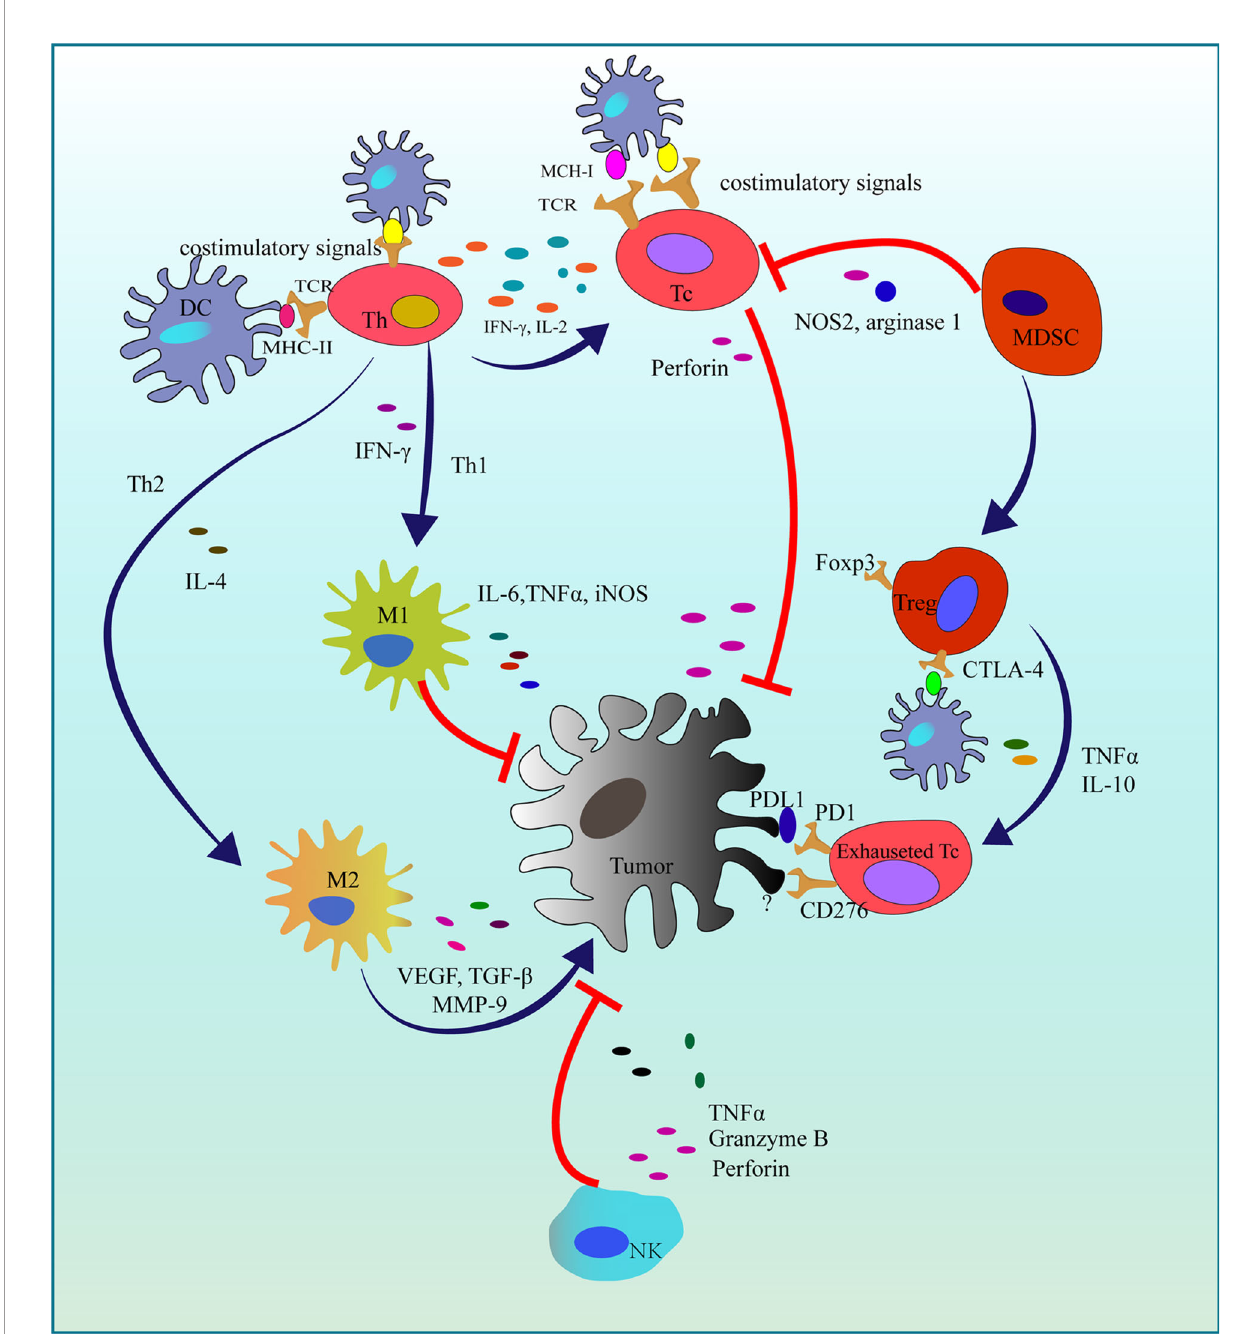
FIGURE 3 | Immune responses in the tumor microenvironment. In the initiation of tumorigenesis, activated Tc and NK cells suppress tumor proliferation. While in the immune evasion, Th2 recruits MDSC and promotes macrophages polarization (M1 to M2). Finally, survived tumor cells exhaust Tc cells by some immune checkpoints. DC, Dendritic cell; MCH-1, Major histocompatibility complex class I; MCH-II, Major histocompatibility complex class II; TCR, T cell receptor; Th, T helper cell; Th1, T helper 1 cell; Th2, T helper 2 cell; Tc, Cytotoxic T cell; IFN- g , Interferon-gamma; Treg, Regulatory T cell; Foxp3, Forkhead box Protein 3; MDSC, Myeloid- derived suppressor cell; NOS2, Nitric Oxide Synthase 2; TNF a , Tumor necrosis factor-alpha; IL-2, Interleukin 2; IL-6, Interleukin 6; iNOS, Inducible nitric oxide synthase; M1, Macrophage 1; M2, Macrophage 2; PD-1, Programmed cell death protein 1; PD-L1, Programmed cell death protein ligand 1; CTLA-4, Cytotoxic T- lymphocyte antigen 4; NK, Natureal kill cell; TGF- b , Transforming growth factor-beta; MMP-9, Matrix metallo proteinase-9; VEGF, Vascular endothelial growth factor; ┤ ,Inhibition; ! ,